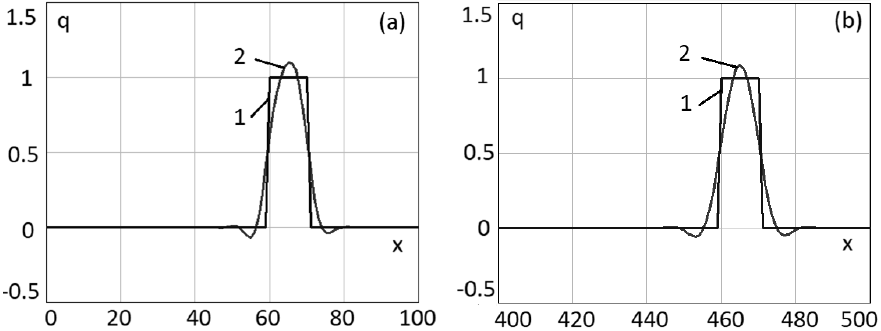
Figure 2. Solutions of the test problem I for various intervals in time: ( a )—100 s, ( b )—500 s; 1—exact solution, 2— numerical solution based on linear combination of the Upwind and Standard Leapfrog difference schemes